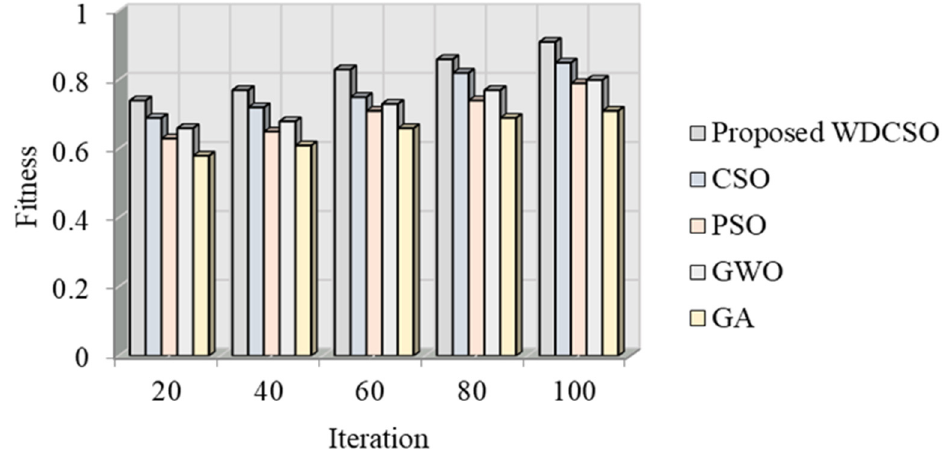
Figure 13. Fitness vs. iteration analysis.